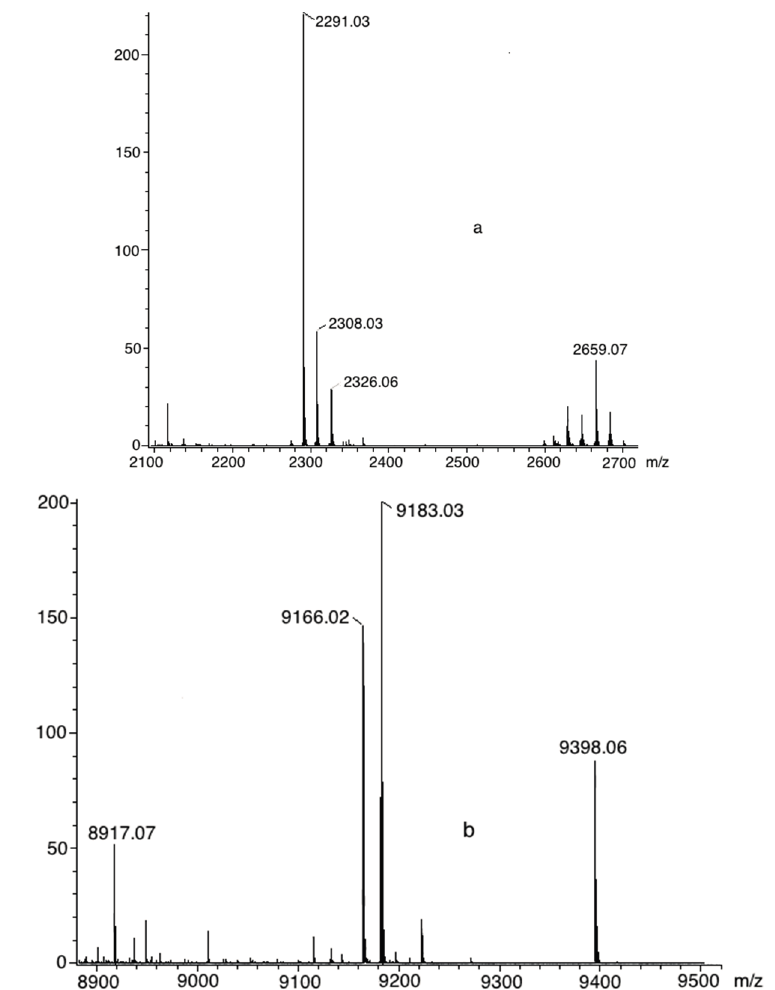
Figure 1. MALDI-TOF mass spectra of dendrimers 6 ( a ) and 7 ( b